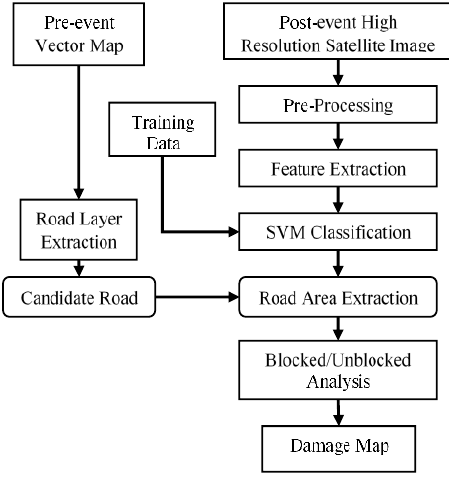
Fig.1: The flowchart of the suggested method for detection of un- blocked paths using satellite images with high separation